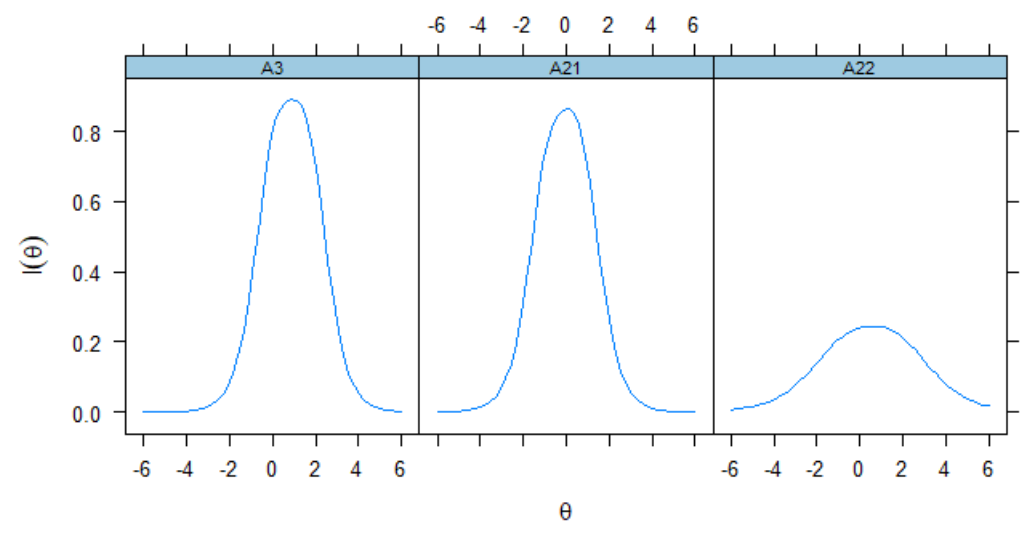
Figure 7. TICs of the Social Recognition Needs component.